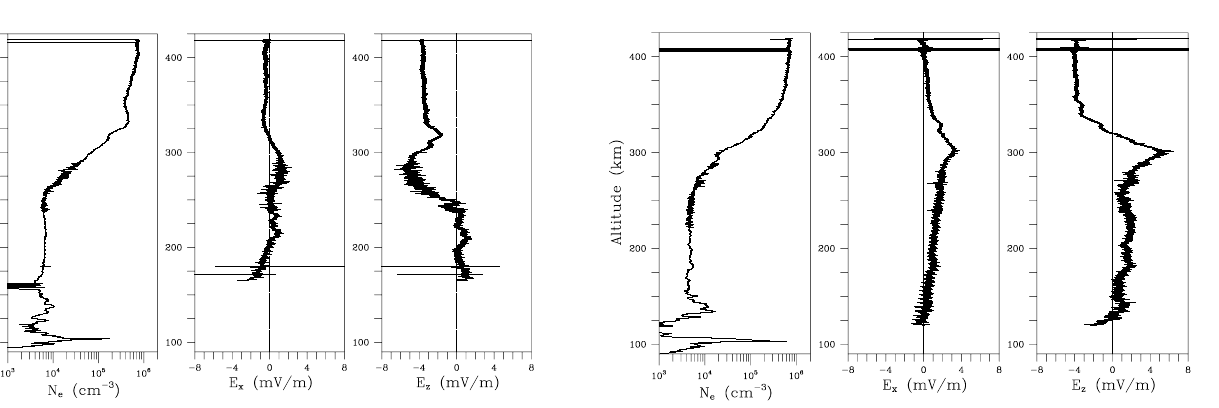
Fig. 14. Downleg data from the 15 August rocket flight. Left panel: electron density. Center panel: zonal electric field. Right panel: vertical electric